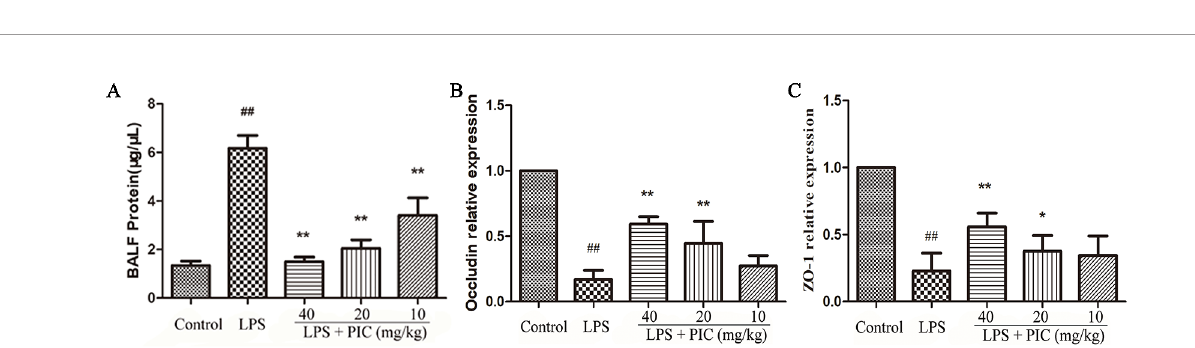
FIGURE 8 | The gene expressions related to cell adhesion molecules and chemokine. The messenger RNA (mRNA) expression including (A) CD62L, (B) CD11a, (C) MCP-1, (D) ICAM-1, was examined by quantitative real-time (qRT)-PCR. ## p < 0.01 is signi fi cantly different from the control group; ** p < 0.01 are signi fi cantly different from the lipopolysaccharide (LPS) group.